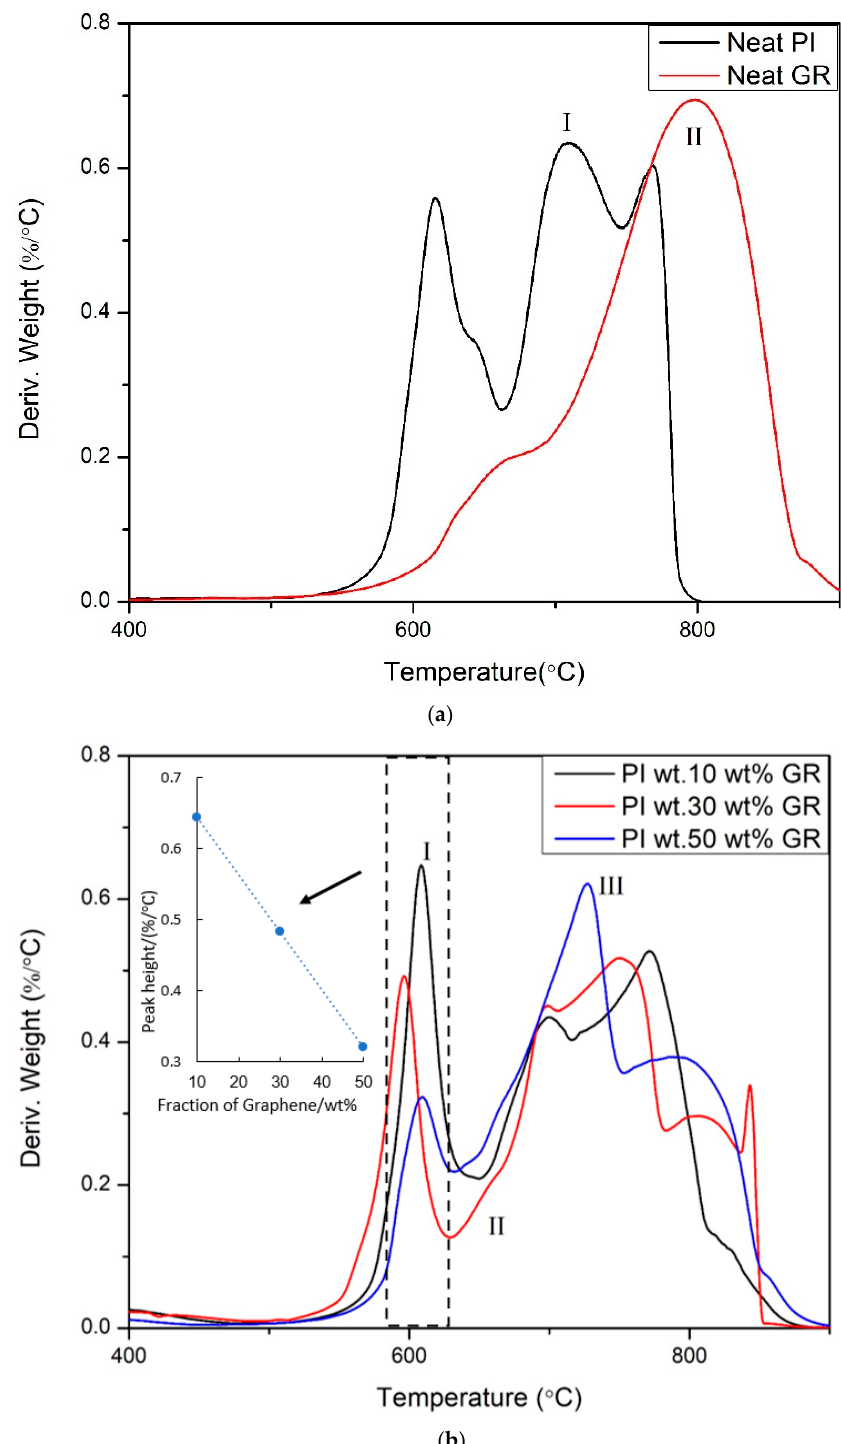
Figure 7. ( a ) DTA curves of (I) Neat PI and (II) neat graphene tested in air with a heat rate of 30 °C/min [99], ( b ) DTA curves of PI-GR composites: (I) PI-10% graphene, (II) PI-30 wt.% graphene, and (III) PI-50 wt.% graphene and comparison of imide decomposition (~600 ° C) peak height (tested in air with a heat rate of 30 ° C/min) [99].